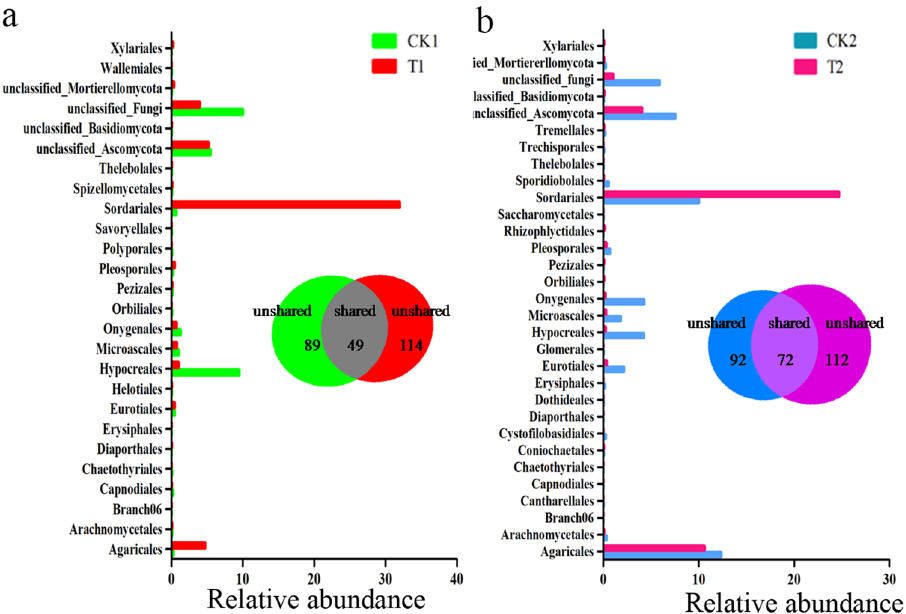
Figure 7. Relative abundance of nodes at the order level in modules inside the fungal network created from the flowering stage ( a ) and fruiting stage ( b ). Venn diagrams display the amount of shared and unshared network nodes in the soil sample with and without wheat straw